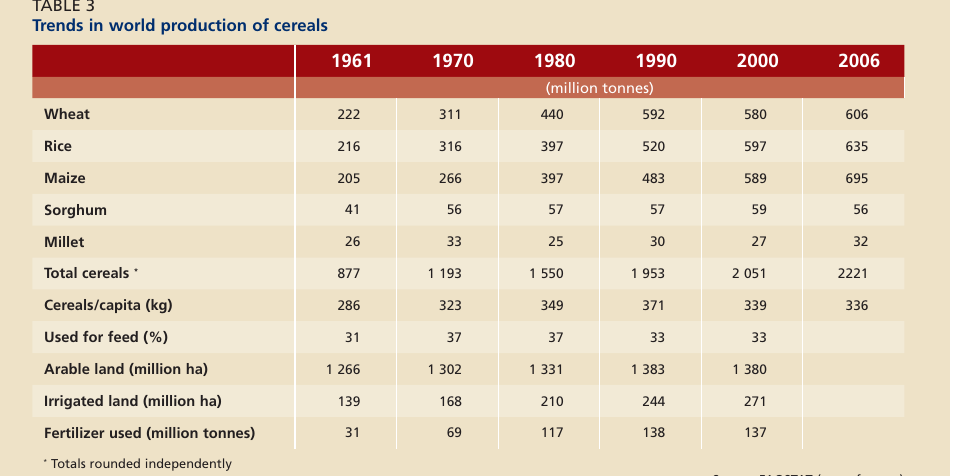
TABLE 3 Trends in world production of cereals